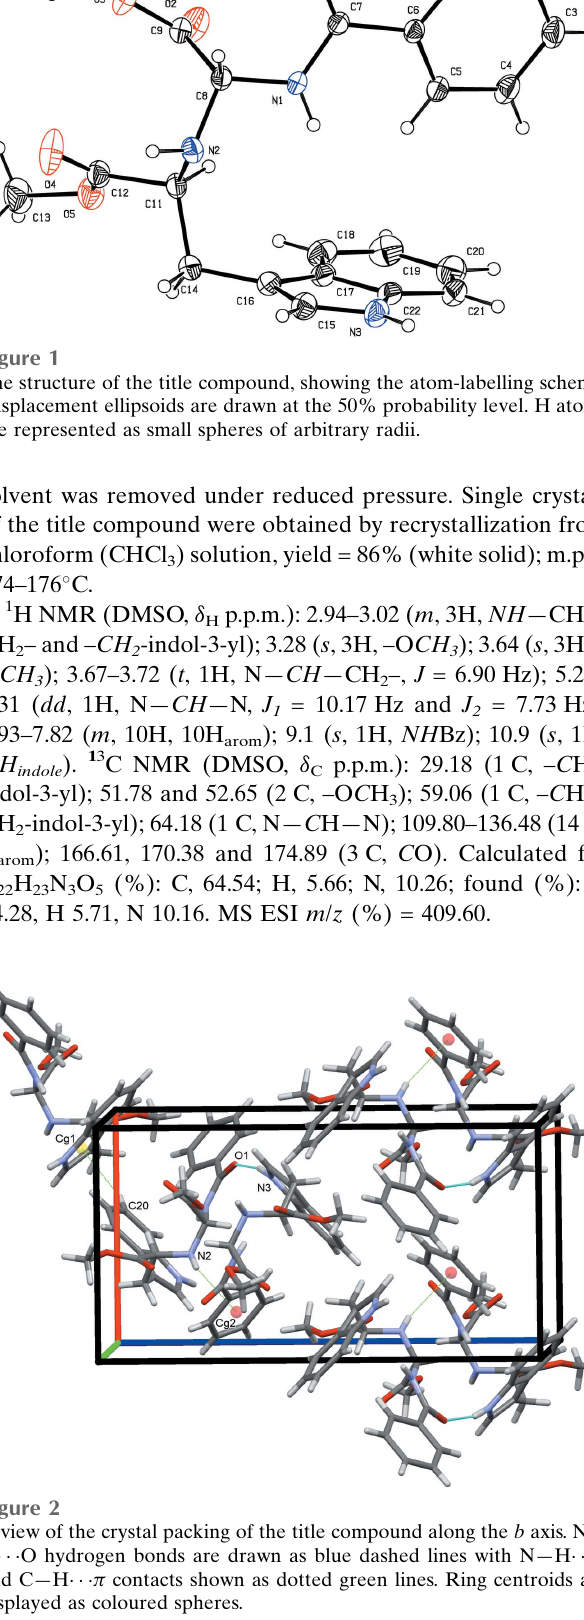
Table 1 Hydrogen-bond geometry (A˚ , (cid:2) ).